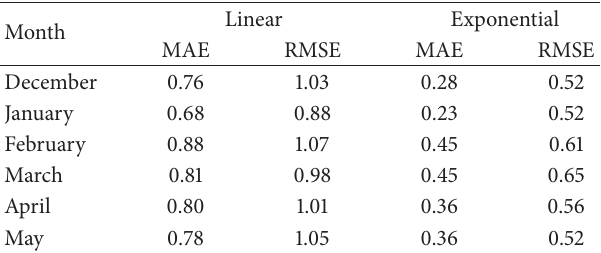
Table 4: Validation for the linear and exponential models for prediction of monthly rainfall from December to